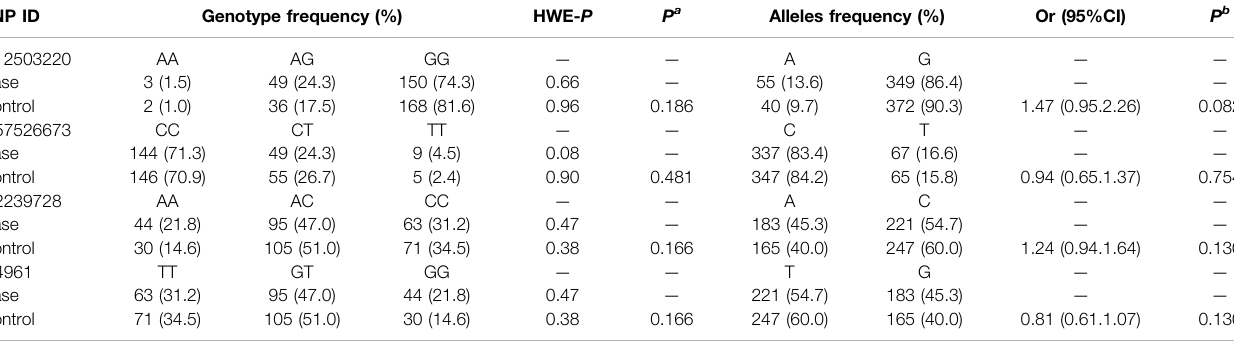
TABLE 7 | Genotypes and allele frequency of ADD1 polymorphism between EH and healthy control patients and their association with EH risk in the Mongolian population